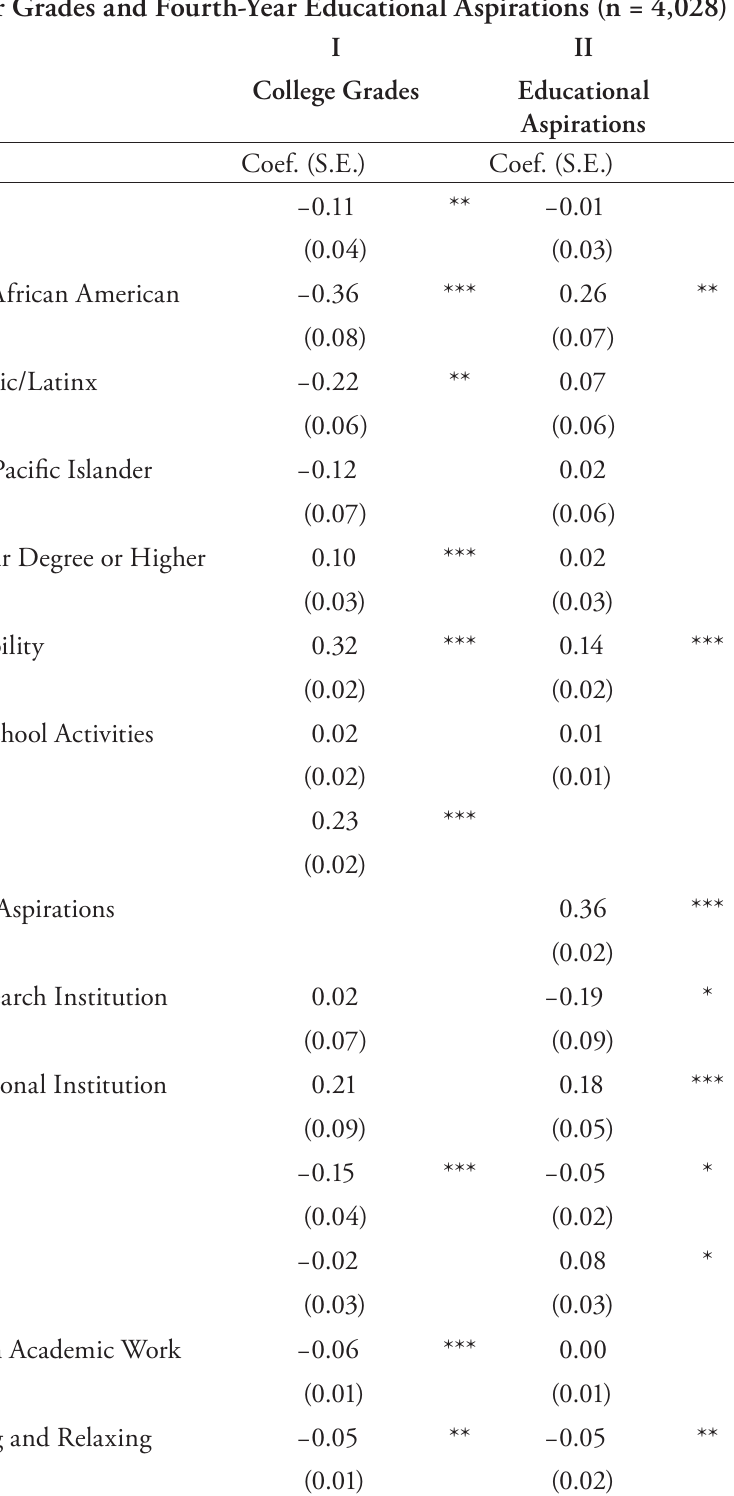
Table 3. Regression Estimates for the Association Between Applied Learning and Students’ Fourth- Year Grades and Fourth- Year Educational Aspirations (n =